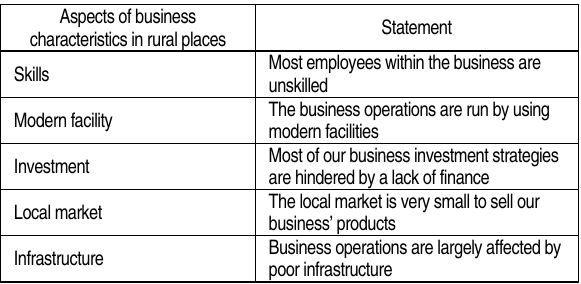
Table 2. Summary of key questions